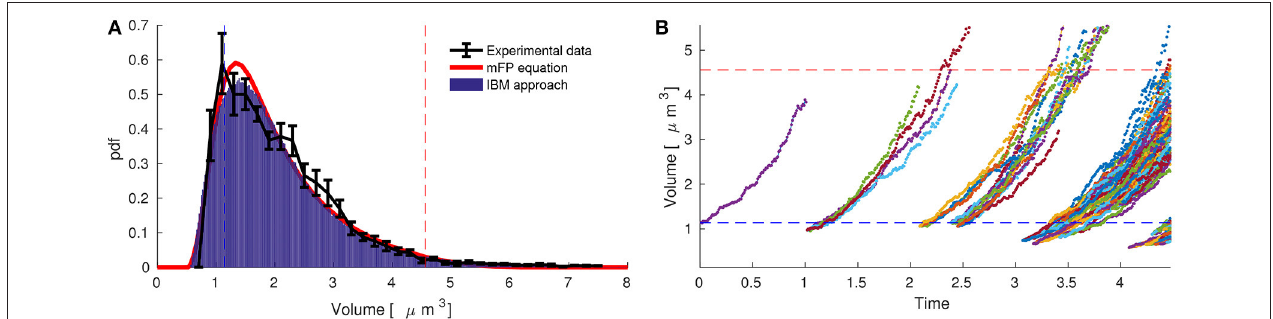
FIGURE 3 | The modified Fokker-Planck equation allows us to estimate single-cell behavior of Pediococcus acidilactici from acquisition based on cytometry data at one sampling time within the exponential phase. (A) The stationary distribution of Pediococcus acidilactici (black line) coincides with the modified Fokker-Planck equation (red line) and the individual-based modeling (blue histogram). The single-cell parameters to simulate both models were obtained by minimizing the differences between data and the stationary Fokker-Plank equation. (B) Single-cell dynamics of Pediococcus acidilactici with the estimated parameters. During the cycle of a single-cell, the volume growths four times and it divides in four